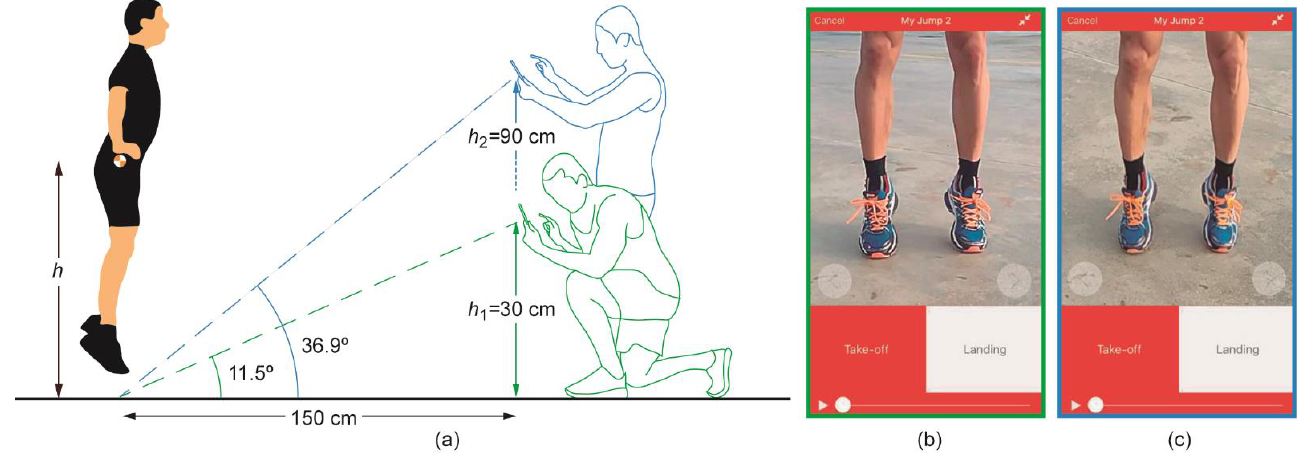
Figure 1. ( a ) Graphical illustration of the experimental setup for observations at two observation heights and their associated screenshots of the same jump execution for h 1 ( b ) and h 2 ( c ). Heights and angles are not to scale. Both smartphones were located on tripods at the two observation heights.